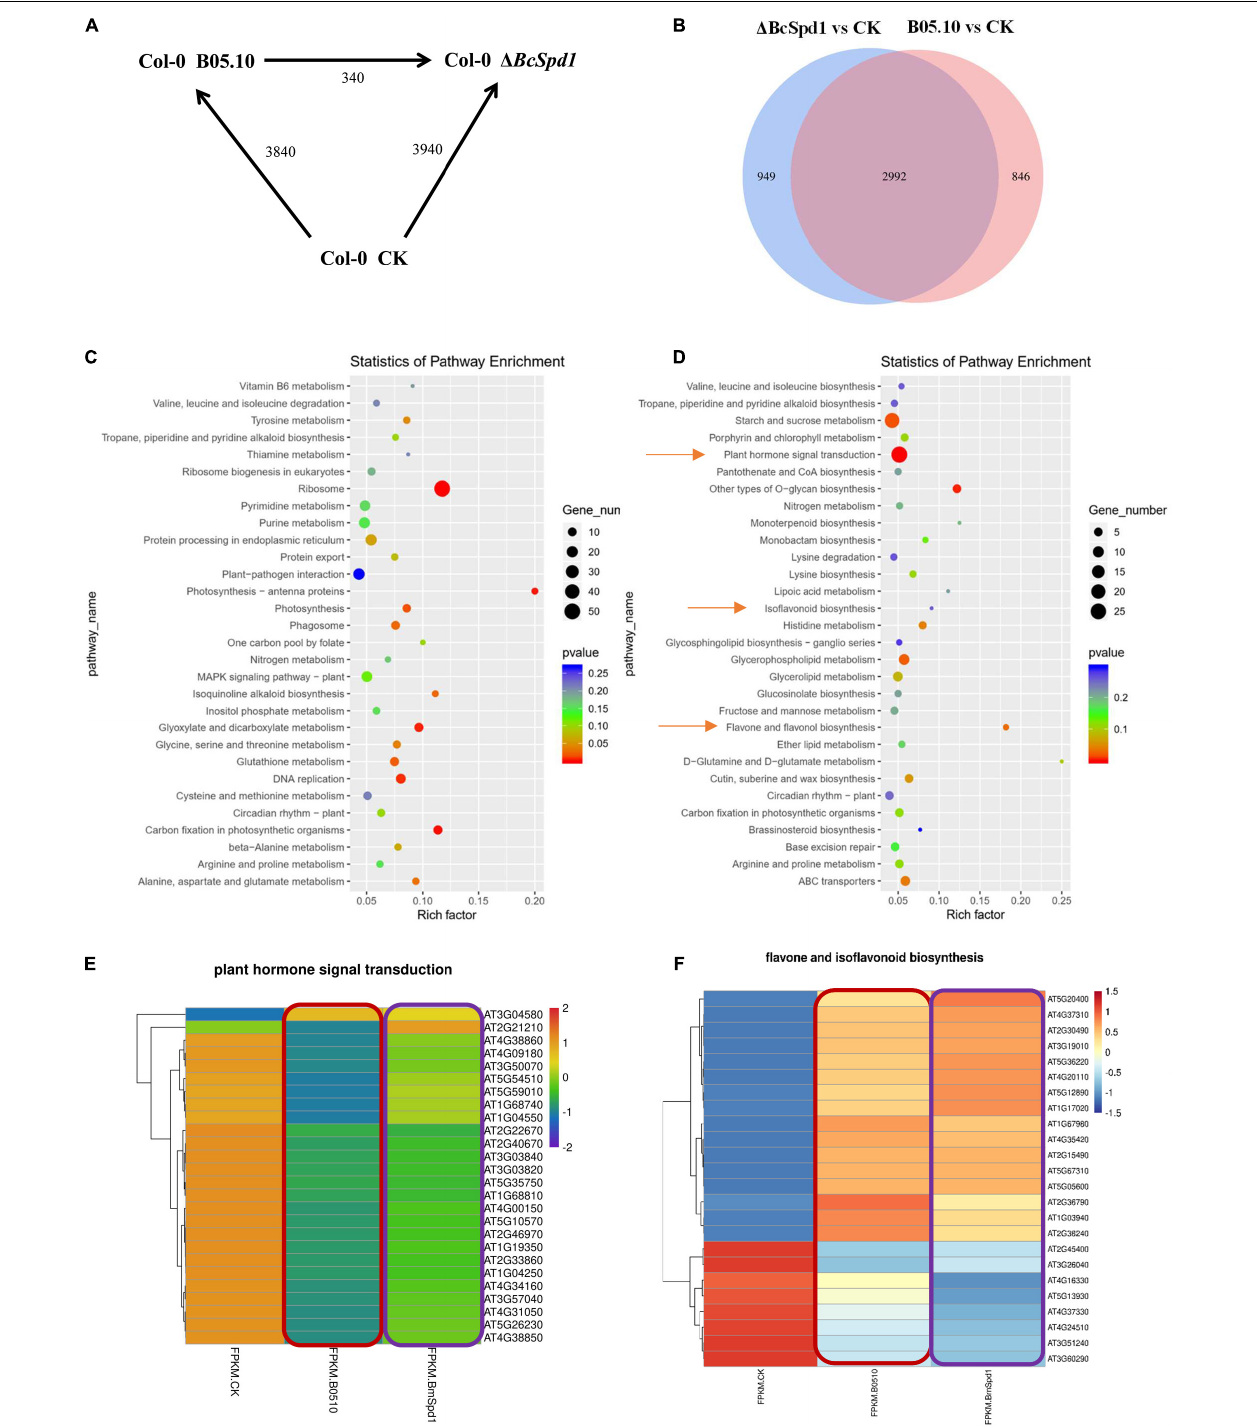
FIGURE 7 | Transcription analysis of B. cinerea B05.10- and (cid:49) BcSpd1 -infected A. thaliana Col-0 plants. (A) Number of differentially expressed genes ( ≥ 2-fold; P ≤ 0.05) in Col-0 at 14 h after mock treatment (CK) or B05.10 or (cid:49) BcSpd1 spray inoculation. The total number of genes between treatments or fungal strains is indicated. (B) Gene analysis of the overlap genes between B05.10-affected and (cid:49) BcSpd1 -affected differentially regulated genes. (C) KEGG analysis of differentially expressed genes only observed in B05.10-affected plants. (D) KEGG analysis of differentially expressed genes only observed in (cid:49) BcSpd1 -affected plants. (E) A heatmap analysis of differentially expressed genes in the plant hormone transduction pathway among CK, B05. 10-, and (cid:49) BcSpd1 -treated Col-0 plants. (F) A heatmap analysis of differentially expressed genes in the flavone and isoflavonoid biosynthesis pathways among CK, B05. 10-, and (cid:49) BcSpd1 -treated Col-0 plants.